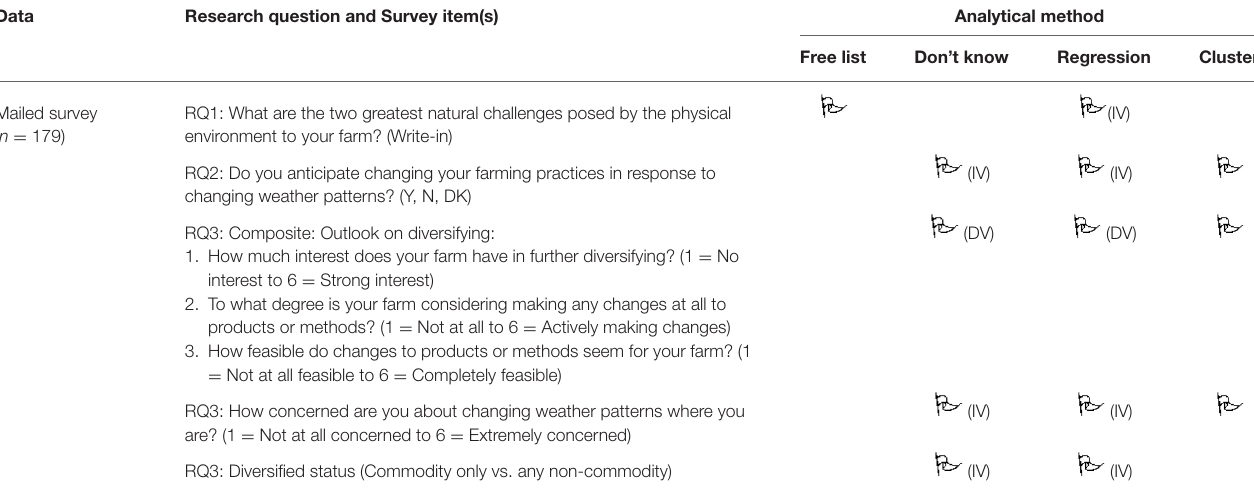
TABLE 1 | Diagram of methods.